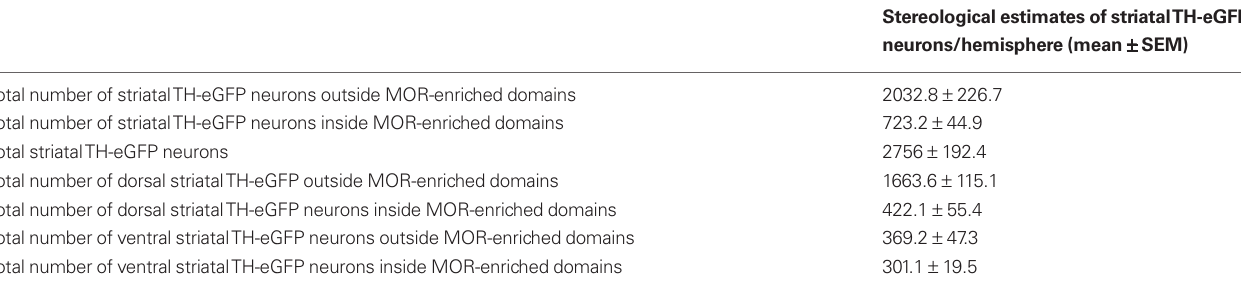
Table 1 | Stereological estimates of the number of TH-eGFP neurons from 60 μm serial sections at 300 μm intervals that were used for stereological counting and mapping of TH-eGFP neurons with respect to